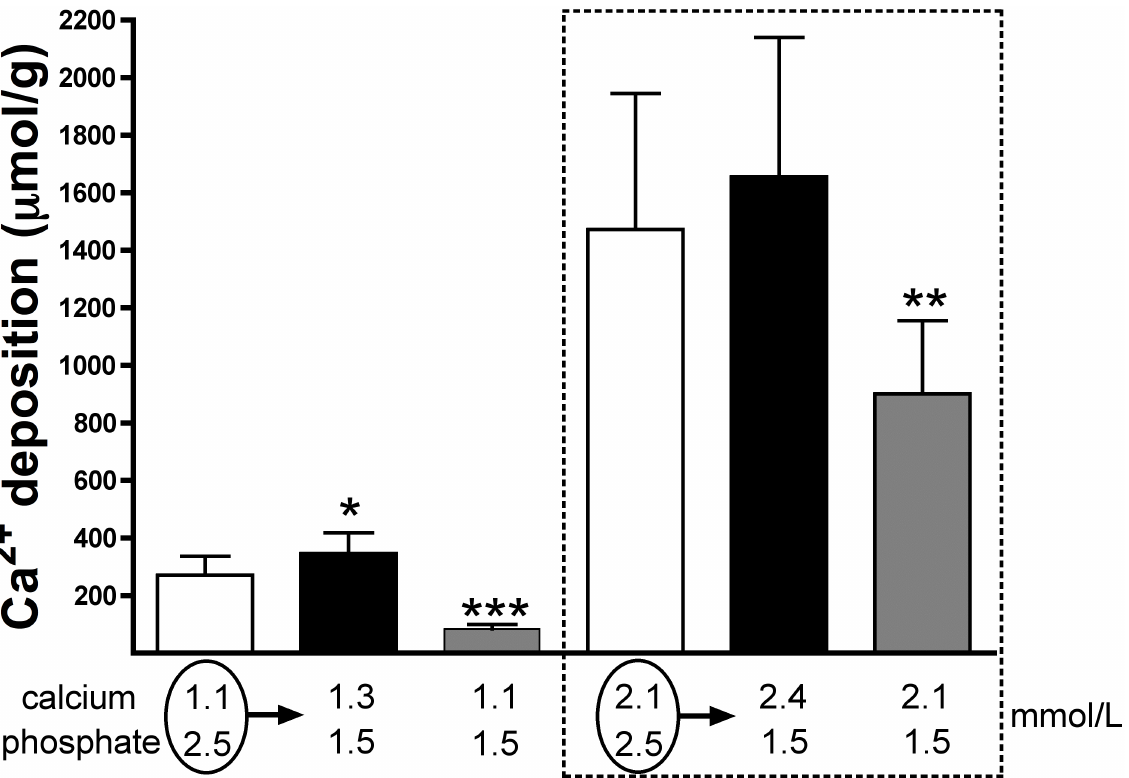
Fig 3. Calcium deposition in the rat aortic wall ex vivo under calcium and phosphate concentrations matching pre- and post-haemodialysis levels in haemodialysis patients. Rat aortic rings were incubated ex vivo in MEM medium containing the indicatedconcentrations of calcium and phosphate. The medium was replacedevery 2 days and contained 45 calcium as a radiotracer.After 6 days of incubation, aortic rings were dried and radioactivity was measuredby liquidscintillation counting.Results are representedas mean ± SD from three independentexperiments, with 15 or 16 rings per condition(five or six rings per condition per experiment). One-way ANOVA and Tukey’s multicomparison test were used for statistical analysis. Calcium and phosphate concentrations are in mmol/L. * p < 0.05; *** p < 0.001 . Pre-dialysisconditionswere used as a reference. PreHD ,pre- haemodialysis; PostHD ,